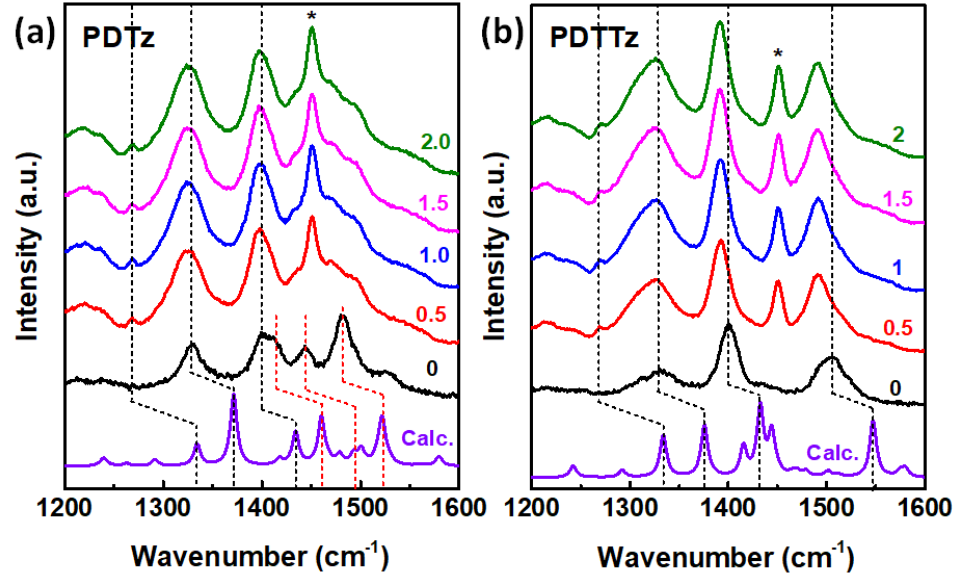
Figure 4. Raman spectra of ( a ) PDTz and ( b ) PDTTz films depending on the F4TCNQ doping ratio.